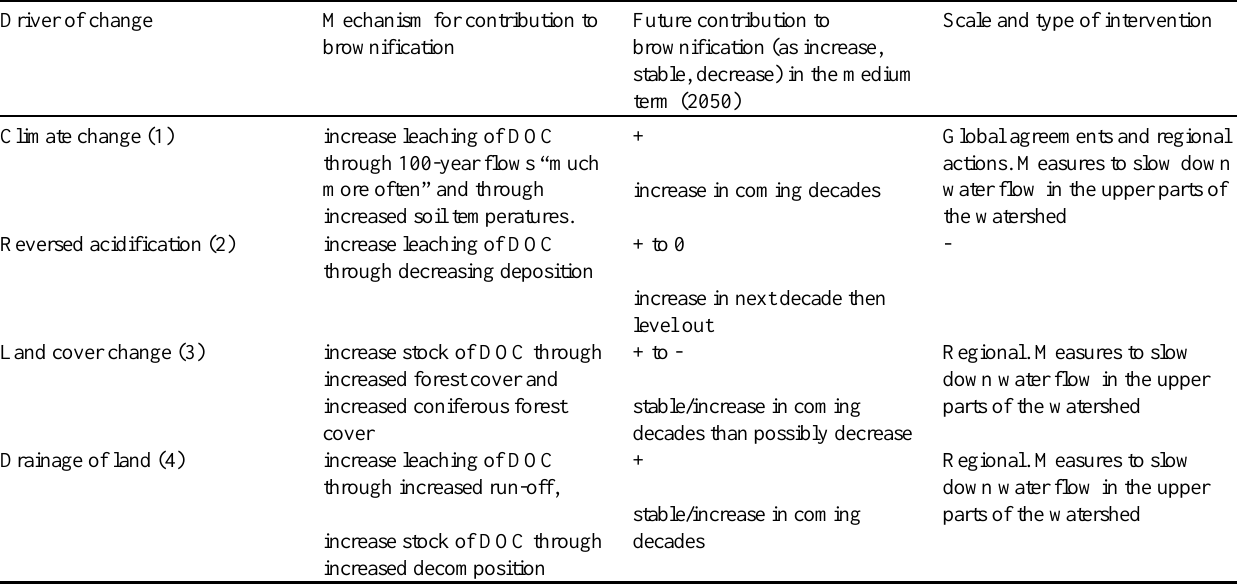
Table 2 . A future scenario for brownification, increasing water color due to increasing levels of DOC in surface water, in the River Helge å catchment based on four drivers of